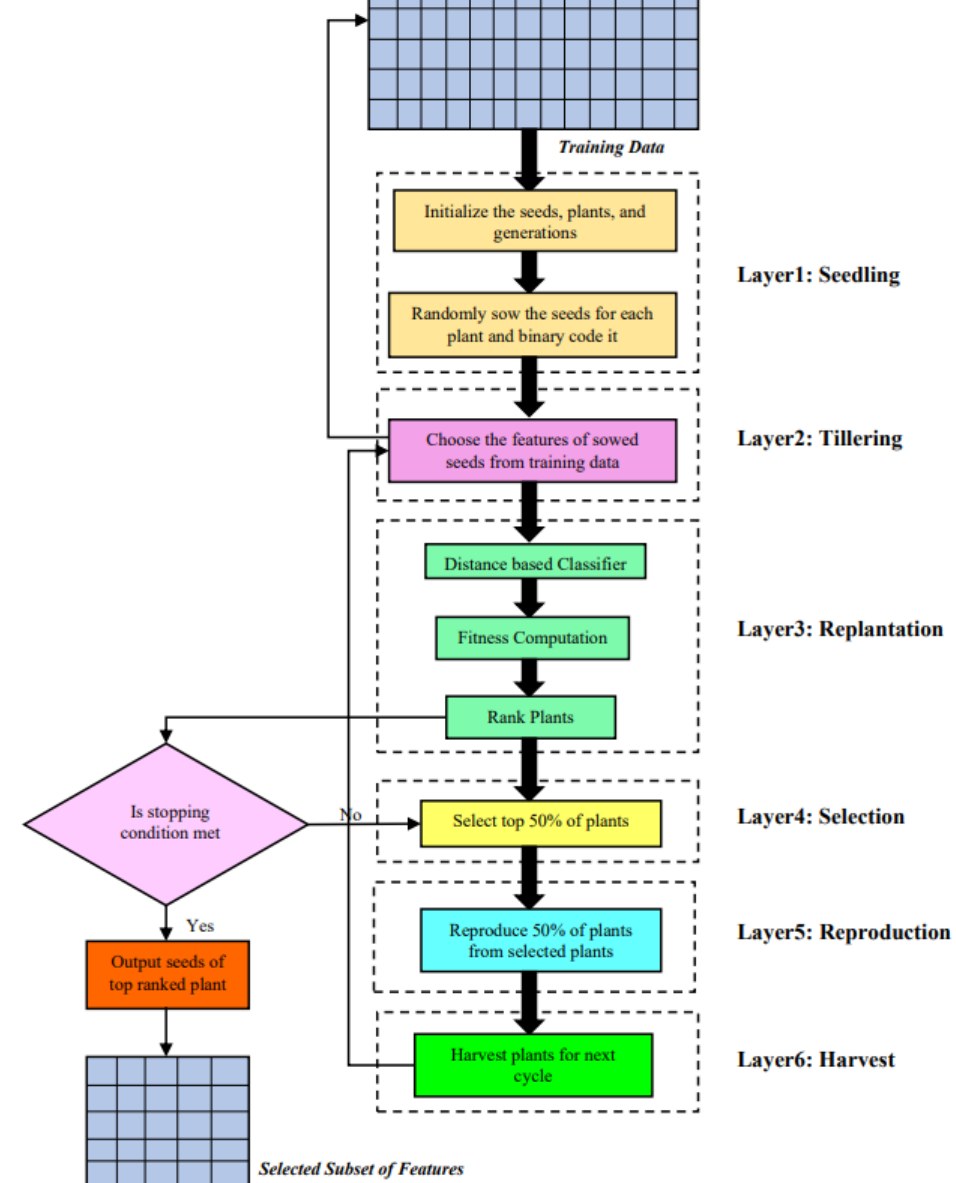
Figure 2. Block schematic of proposed LPCO feature selection